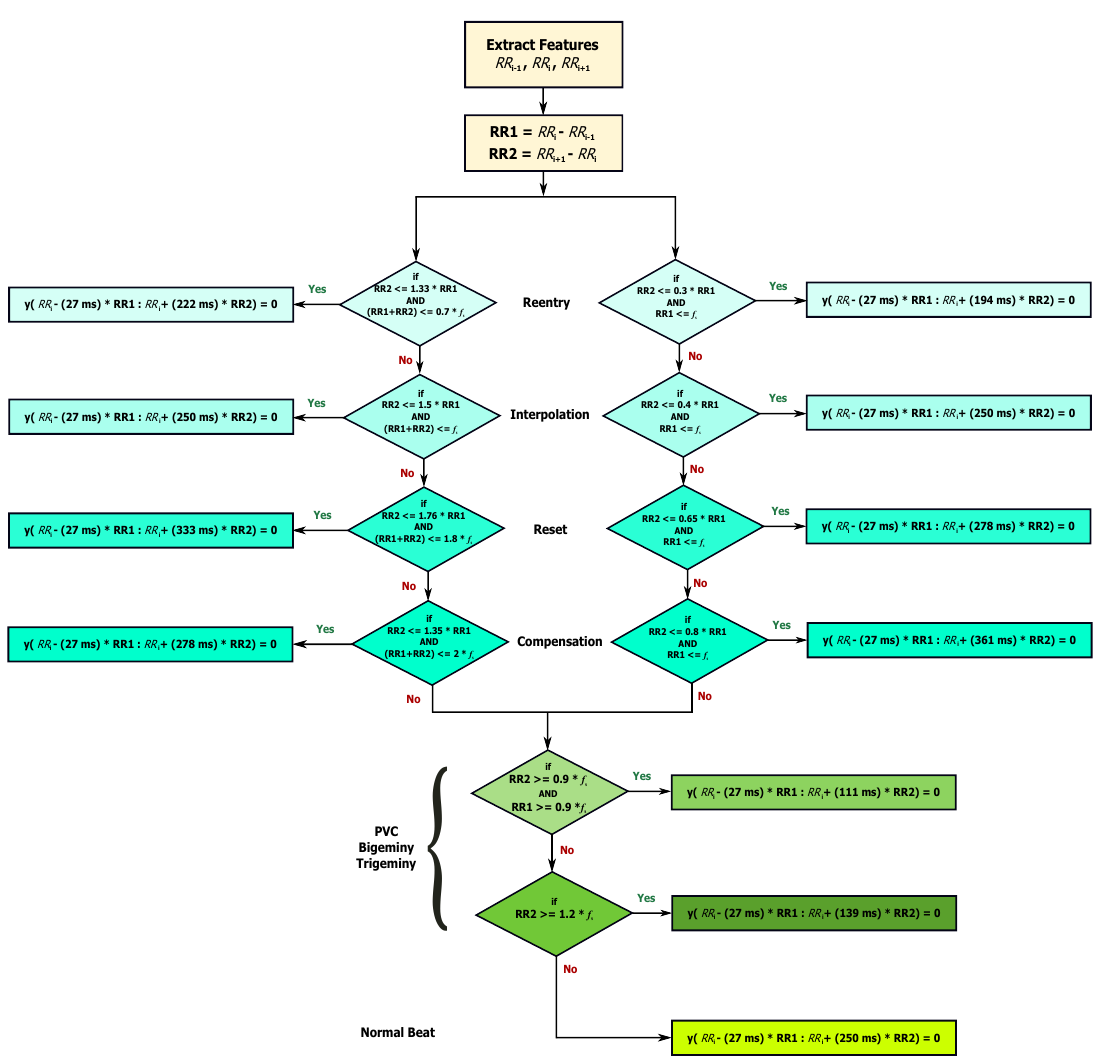
Figure 6. Rule-based knowledge representation of QRS removal based on the clinical knowledge shown in Figure